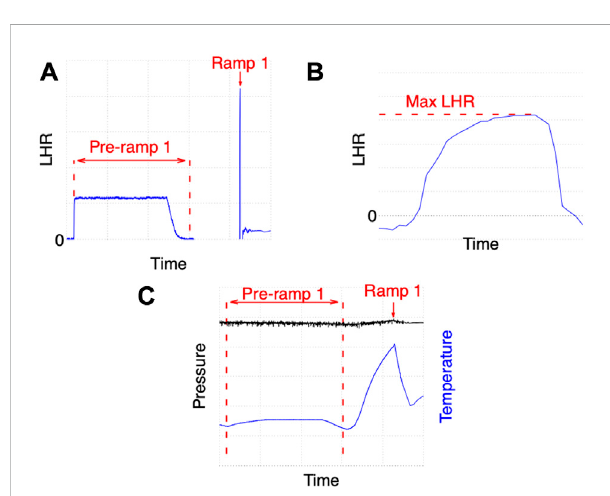
FIGURE 2 (A) LHR during the pre-ramp and cold ramp test (B) LHR during the cold ramp only (C) coolant temperature and pressure during the pre-ramp and cold ramp. Due to the benchmark being on-going, the data on the axes have been